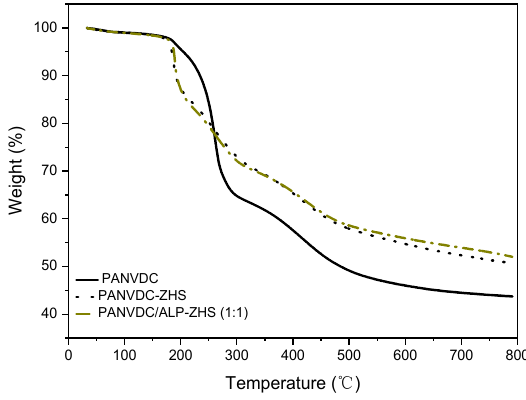
Figure 5. TGA curves of PANVDC, PANVDC-ZHS, and PANVDC/ALP-ZHS (1:1) films.